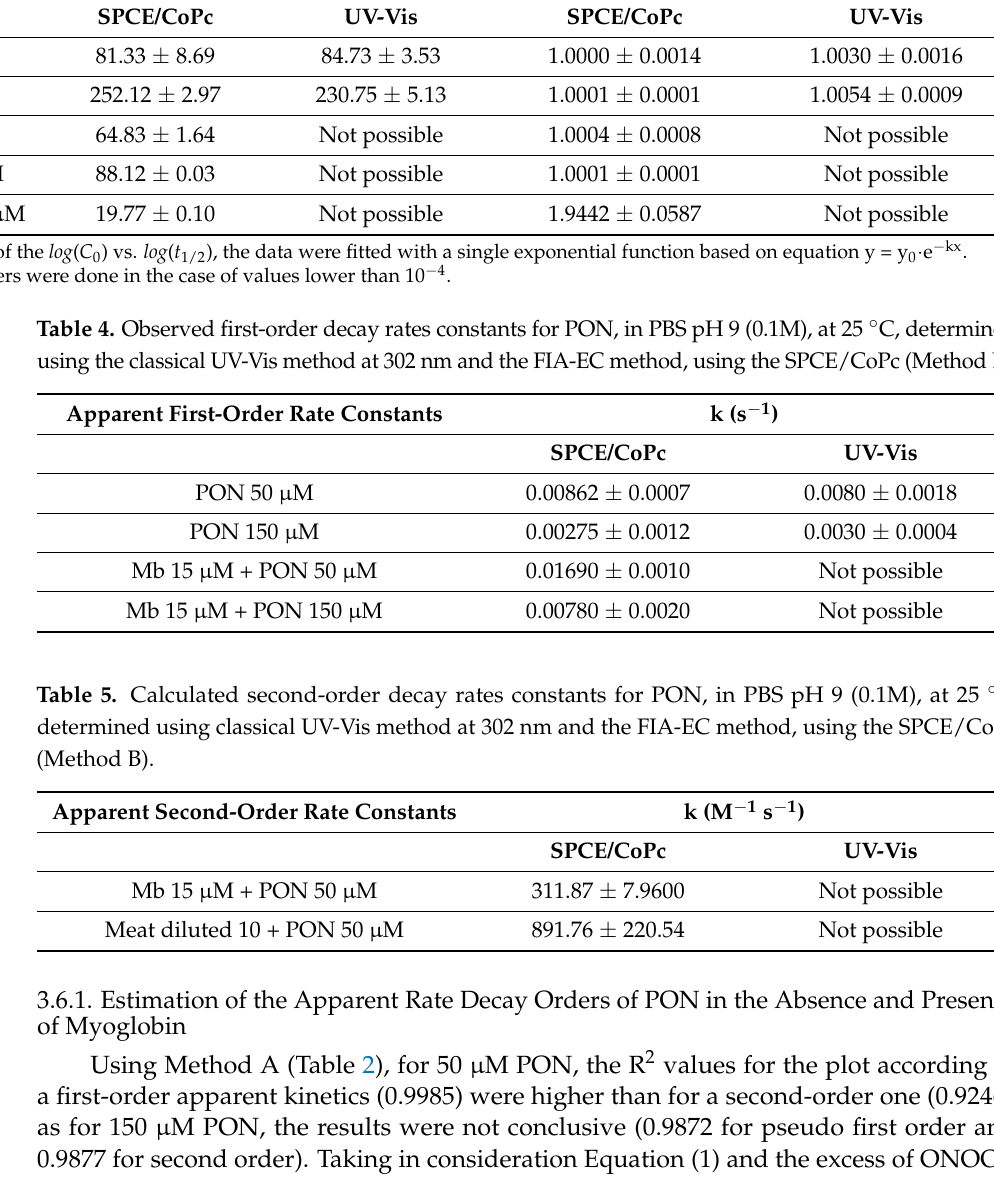
Table 3. The “half-life” method: Determined values of half-life for PON and calculation of rate orders. PBS pH 9 (0.1 M), at 25 ◦ C, classical UV-Vis method at 302 nm and the FIA-EC method, using the SPCE/CoPc (Method B). Half-Lives and Rate Orders t 1/2 (s) Calculated Values for Rate Order *